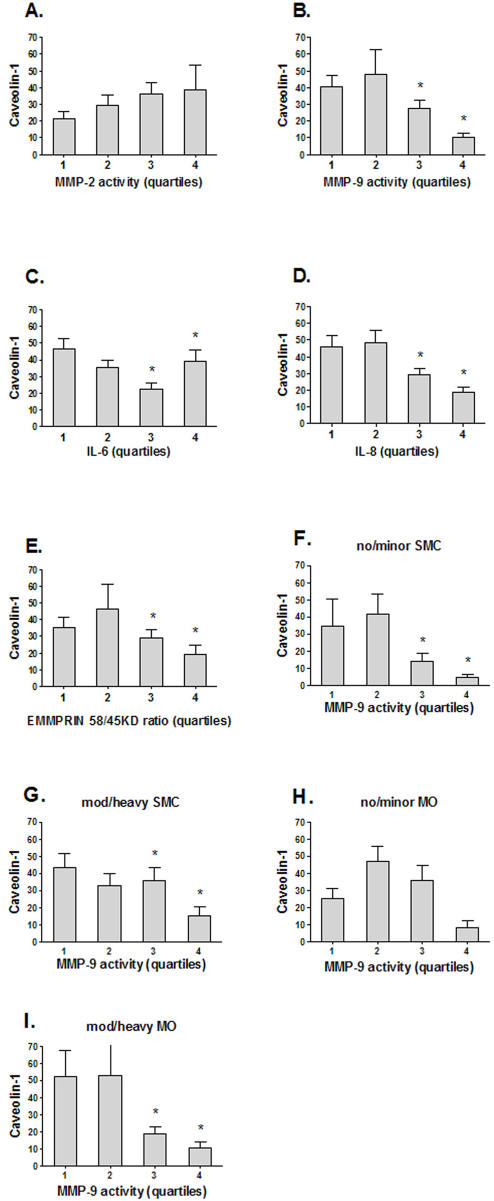
Relationships between Cav-1, Interleukin levels, MMP activity and EMMPRIN levelsA, B, C, D: MMP-2, -9 and IL-6,-8 vs. Cav-1 protein expression levels. E: EMMPRIN 45/58KD ratio vs. Cav-1 protein expression levels. F, G: Analysis of association between MMP-9 and Cav-1 levels in plaques with no or minor smooth muscle cell (SMC) staining vs. plaques with moderate or heavy smooth muscle cell staining. H, I: Analysis of association between MMP-9 and Cav-1 levels in plaques with no or minor macrophage (MO) staining vs. plaques with moderate or heavy macrophage staining. Cav-1 levels are given as mean and standard error. P-values were calculated comparing quartiles 1 and 2 to quartiles 3 and 4 with the Mann-Whitney U test. * denotes p<0.05.